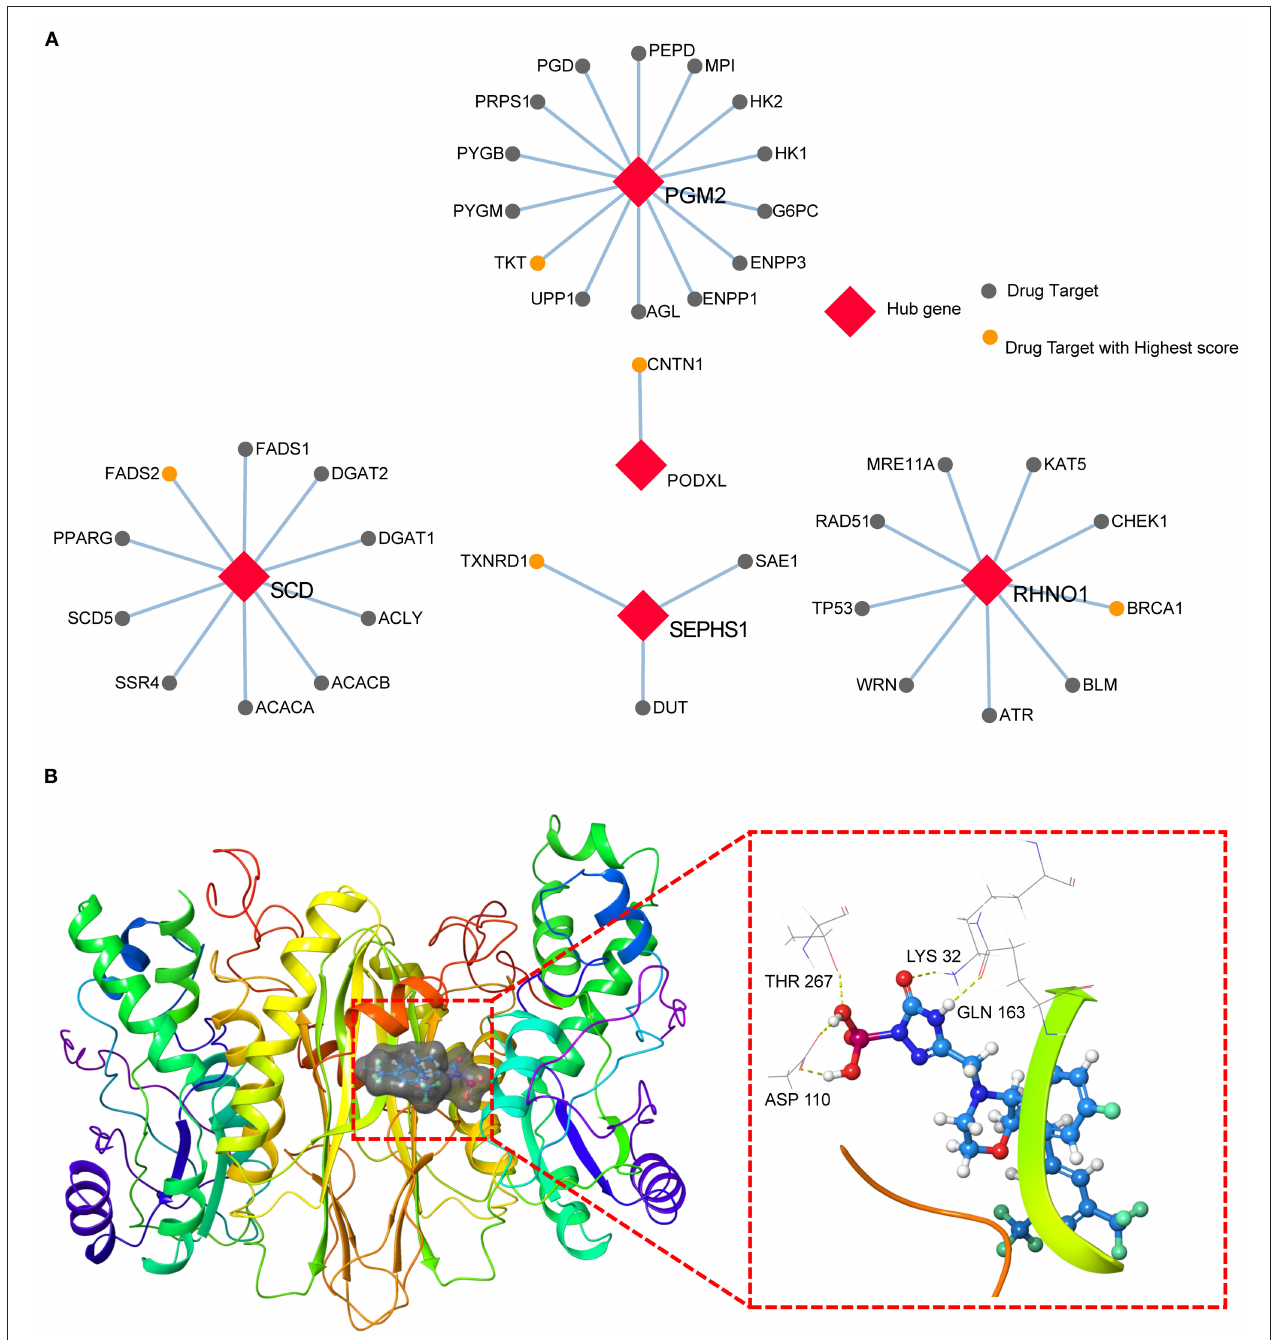
FIGURE 5 | Potential drug-repurposing based on the hub genes for CRC. (A) The PPI network of five hub genes and targets of drugs from the Binding DB database. (B) The ZINC000003939013-SEPHS1 docking complex.